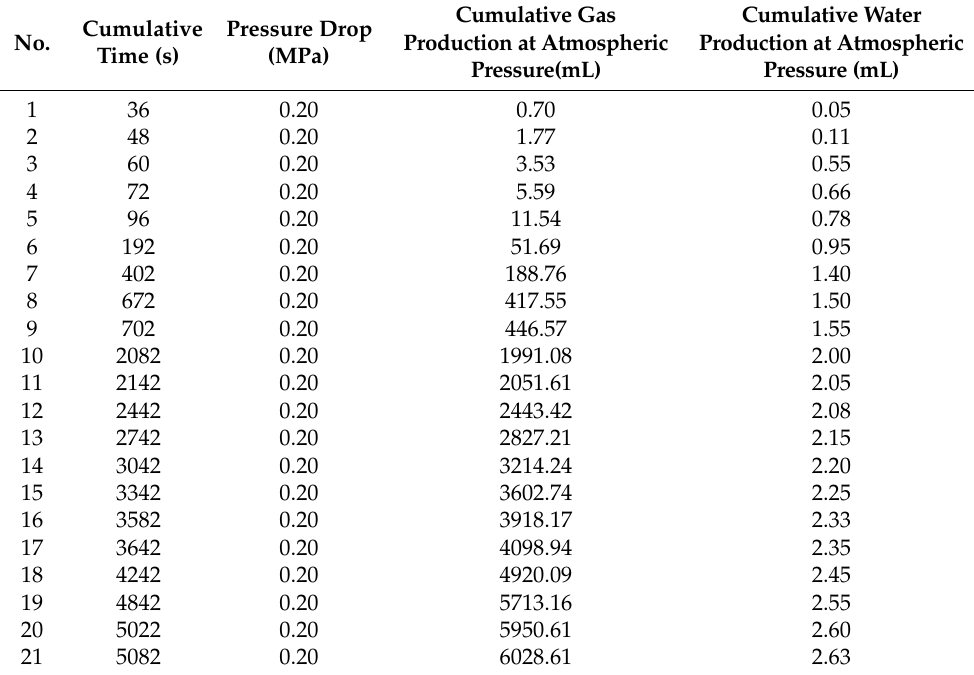
Table A2. The experimental results of No.2 (The mass of saturated water is 4.31 g).